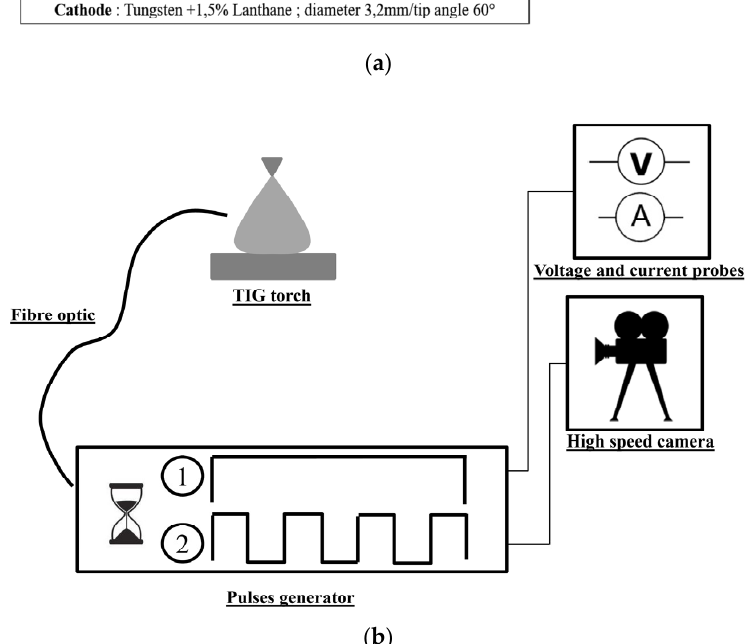
Figure 2. ( a ) Illustration of the experimental setup detail of the torch elements and welding parameters; ( b ) Illustration of the experimental setup synchronization system.